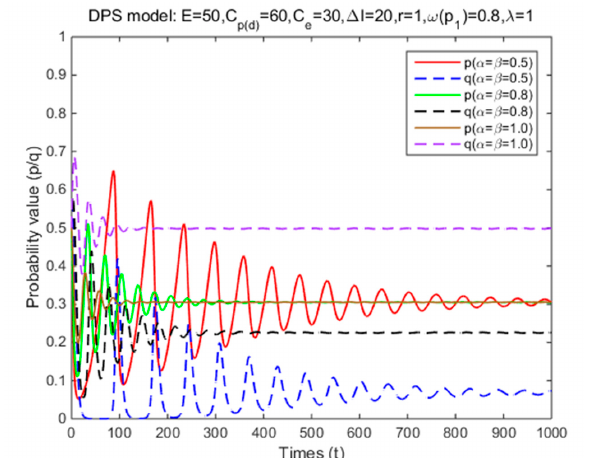
Figure 6. The effects of risk attitude coefficients on strategy probabilities of cyclists and law enforcement under DPS (Situation 3).